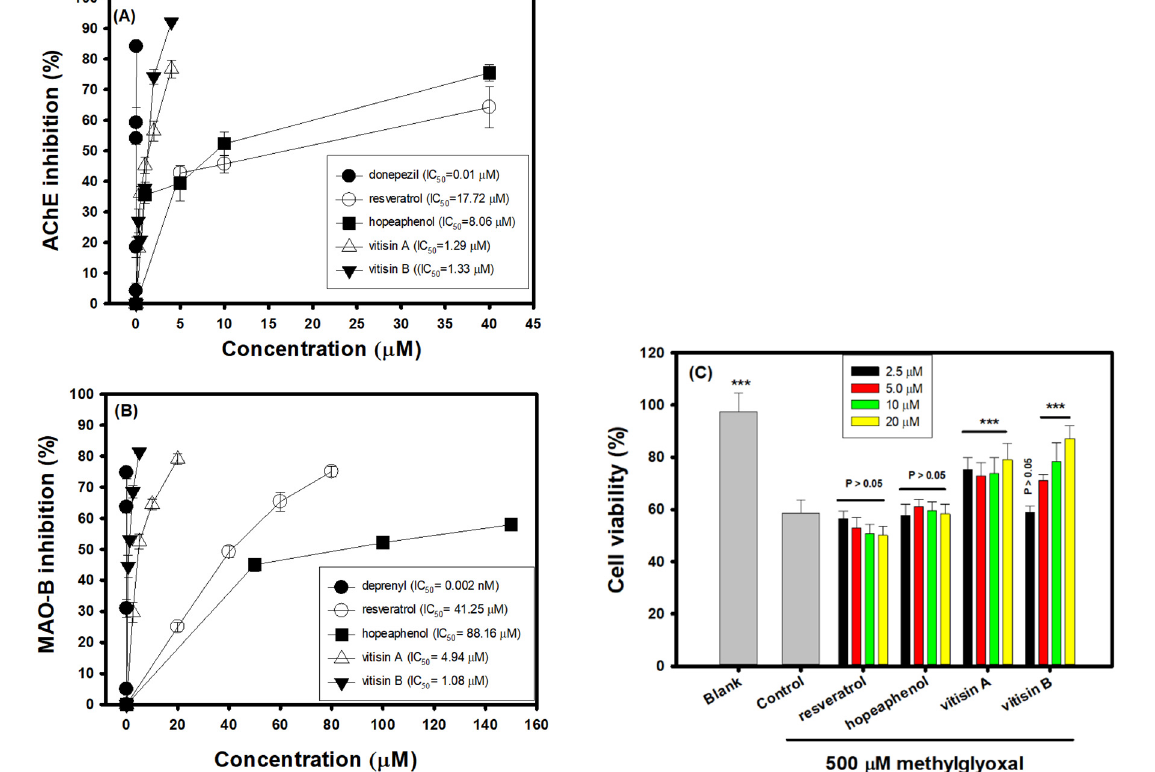
Figure 3. ( A ) Effects of the same molecular mass of resveratrol tetramers, vitisin A, hopeaphenol, and vitisin B, on acetylcholinesterase (AChE) inhibitory activities in comparisons with resveratrol, and the donepezil was used as the positive control; ( B ) Effects of the same molecular mass of resveratrol tetramers, vitisin A, hopeaphenol, and vitisin B, on monoamine oxidase (MAO)-B inhibitory activities in comparisons with resveratrol, and the deprenyl was used as the positive control; ( C ) Effects of resveratrol, vitisin A, hopeaphenol, and vitisin B, on neuroprotective activities (2.5, 5, 10, and 20 µ M) in methylglyoxal-induced SH-SY5Y cell deaths. Data were expressed as mean ± SD of three independent quantitative experiments. The Student’s t -test was used to compare the neuroprotective activity of resveratrol or resveratrol tetramers in 500 µ M methylglyoxal-treated SH-SY5Y cells ( C ) with the control. The different cell viability was considered as the significant differences when p < 0.001